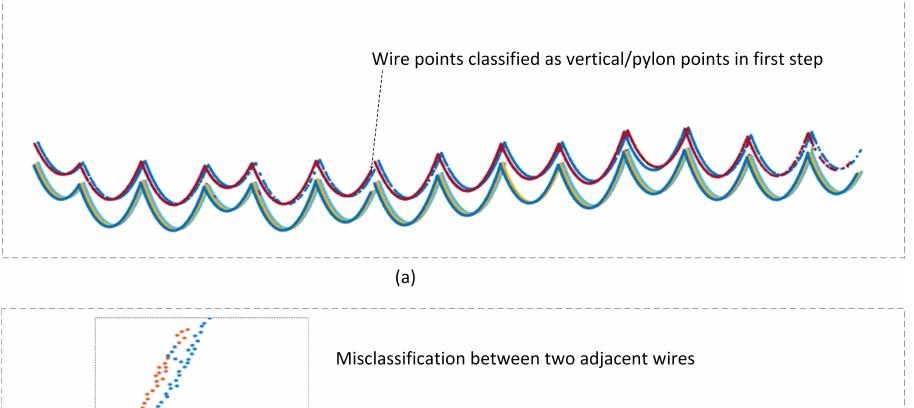
Table 3. point-based evaluation on the dataset.